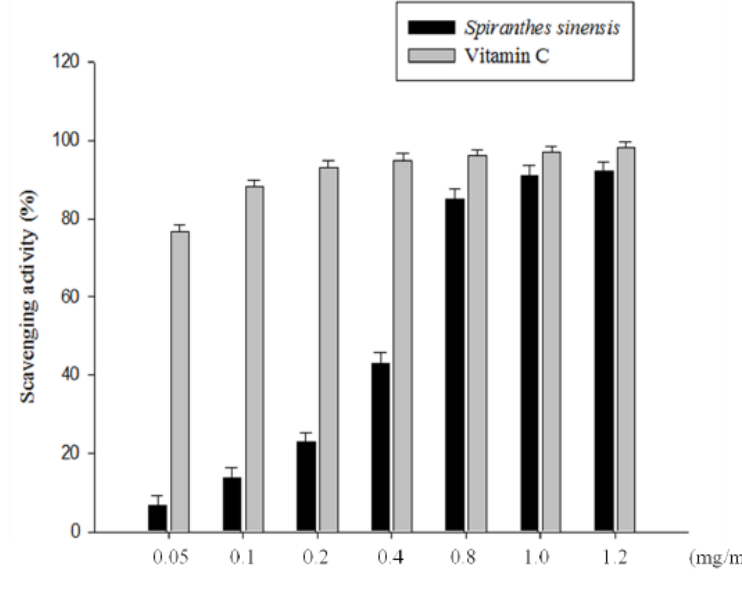
Figure 2. DPPH radical scavenging capacity of S. sinensis E+U extract. The DPPH scavenging effects of the extract at different concentrations compared with vitamin C. Results are represented as percentages of control, and the data are mean ± SD for the three separate